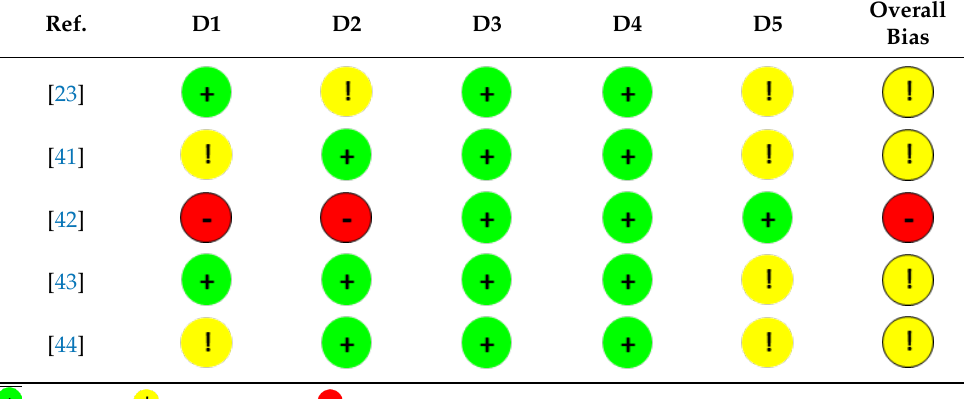
— some concerns — high risk; risk of bias domains: D1 — arising from the ran- domization process; D2 — due to deviations from the intended interventions; D3 — due to missing outcome data; D4 — in measurement of the outcome; D5 — in selection of the reported result.